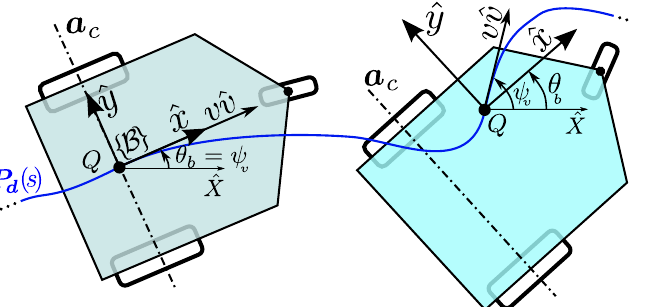
Figure 4. Two WMRs with δ M = 2. For the one on the left, the origin of one on the right, the origin is outside of a c